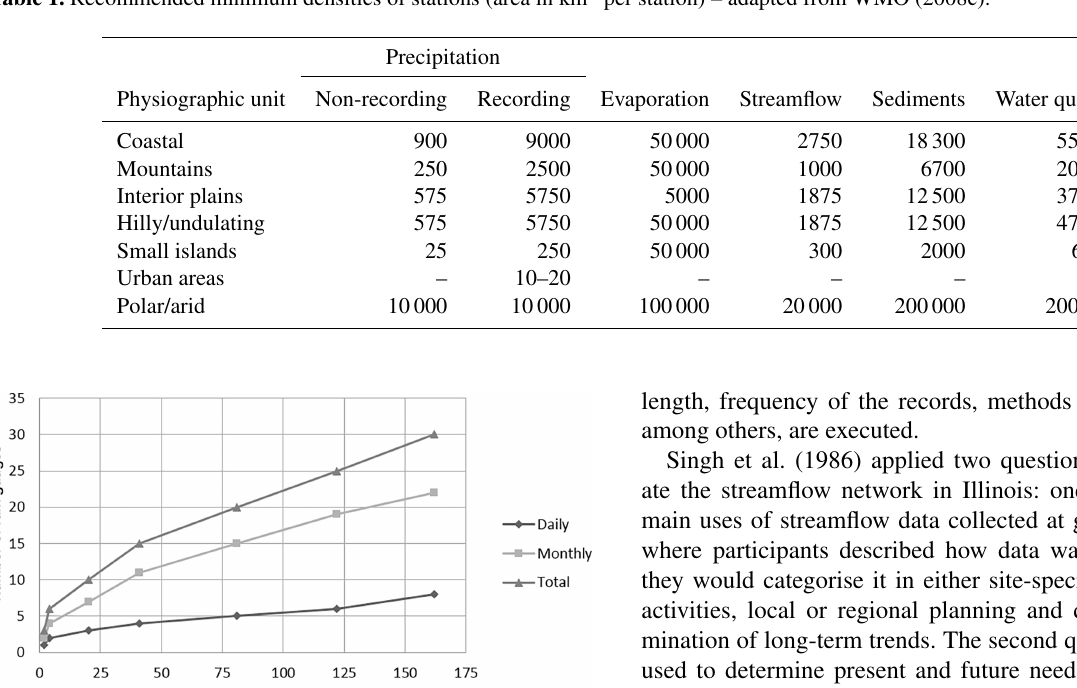
Table 1. Recommended minimum densities of stations (area in km 2 per station) – adapted from WMO (2008c).